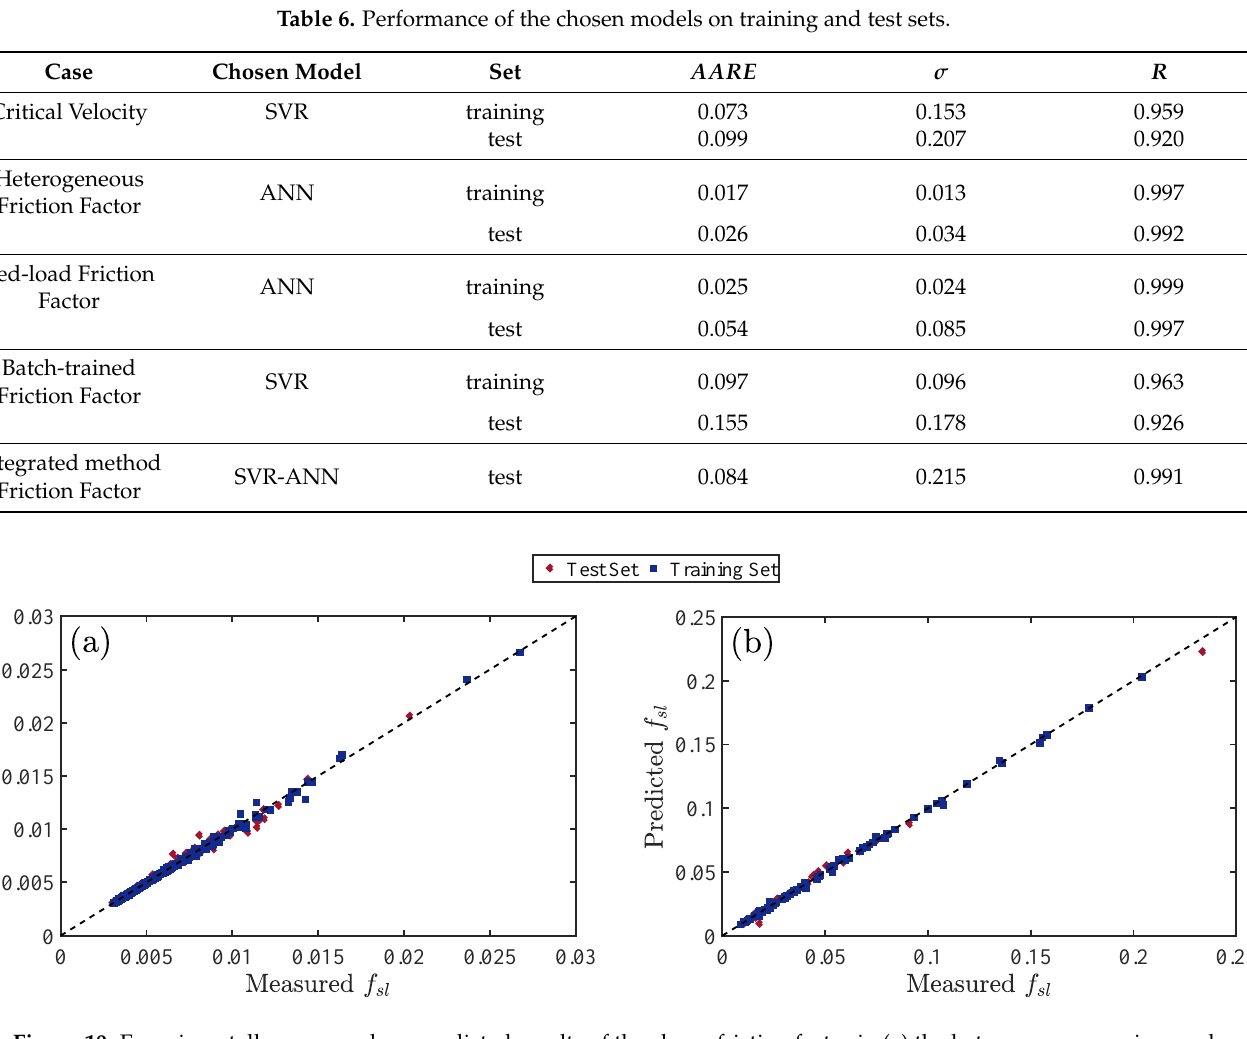
Figure 10. Experimentally measured vs. predicted results of the slurry friction factor in ( a ) the heterogeneous regime and ( b ) the bed-load regime for training and test